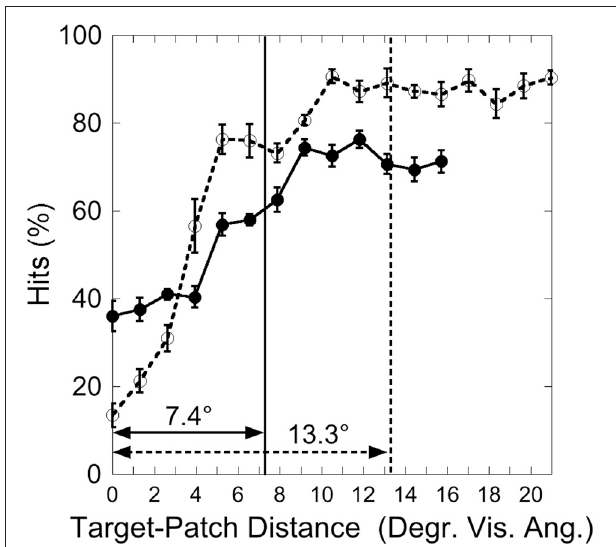
FIGURE 10 | Experiment 3: hits as a function of target-patch distance. Vertical lines represent the critical distance (averaged over participants). Solid lines and filled circles: Central Target condition; dotted lines and unfilled circles: Peripheral Target condition. Black bars depict standard errors.